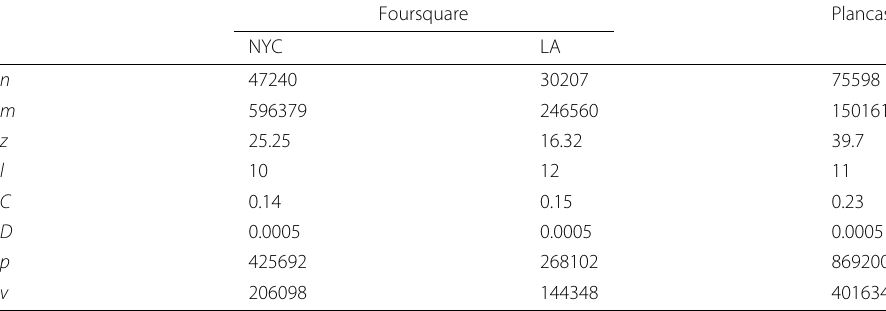
Table 1 Basic statistics of the OSNs used in this study Foursquare